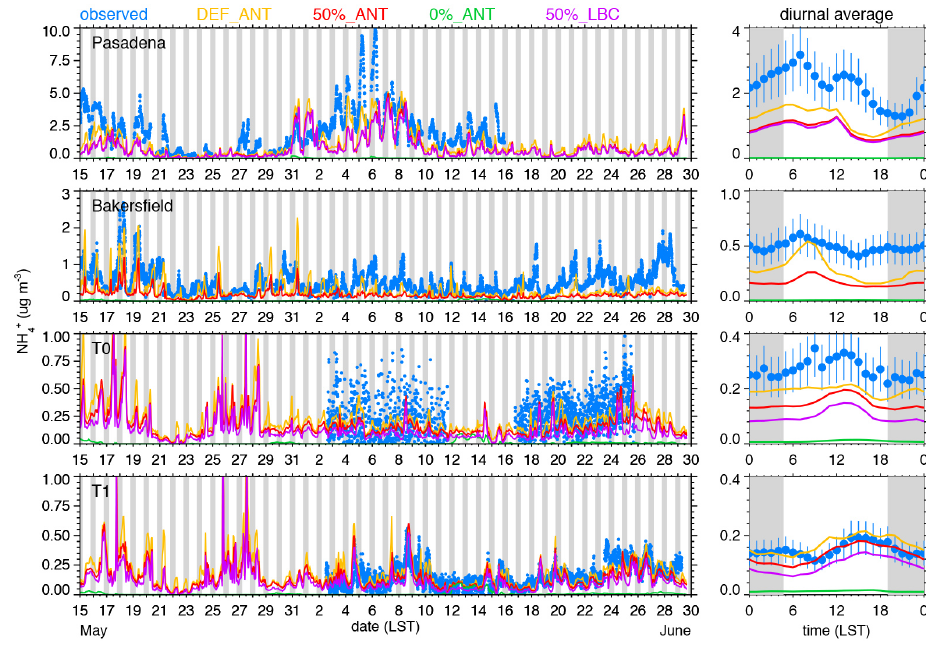
Figure 19. Observed (AMS instrument) and simulated time series (left panels) and average diurnal variation (right panels) of NH + four supersites. Gray shading denote night and vertical lines in right panels denote measurement uncertainty range. Simulated NH + total of the first four model size bins up to 0.625µm